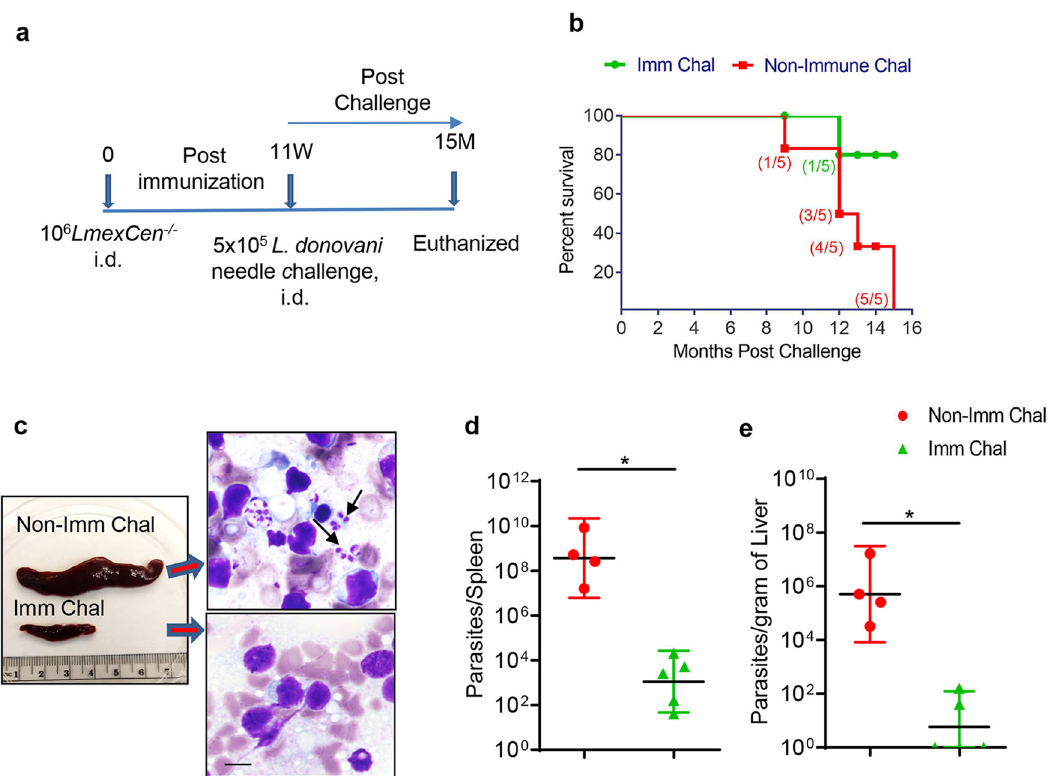
Fig. 3 LmexCen − / − immunization confers protection against L. donovani through needle challenge in hamsters. a Schematic representation of the experimental plan to determine the protection ef fi cacy of LmexCen − / − parasite. b Kaplan – Meier survival curves of LmexCen − / − immunized hamsters (Imm Chal; green lines, n = 5) following challenge with L. donovani and compared with age-matched non- immunized challenged group (Non Imm Chal; red lines, n = 5). c Photographs (left panel) of representative one spleen samples of both LmexCen − / − - immunized and non-immunized hamsters following 12-months of post-needle challenge hamster is shown. Right panel showing stamp smear of respective spleens stained with H&E, black arrows indicates intracellular parasites (bar-20 µm). Parasite loads in the spleen ( d ) and liver ( e ) of hamsters either immunized with LmexCen − / − (Imm Chal, n = 5) parasites or age-matched non-immunized control (Non-Imm Chal, n = 4) were determined by serial dilution method following 9 – 15 months of post-needle challenge with L. donovani . Results (the geometric means with 95% Cl) are from one experiment. Statistical analysis (* p = 0.01) was performed by Mann – Whitney two-tailed